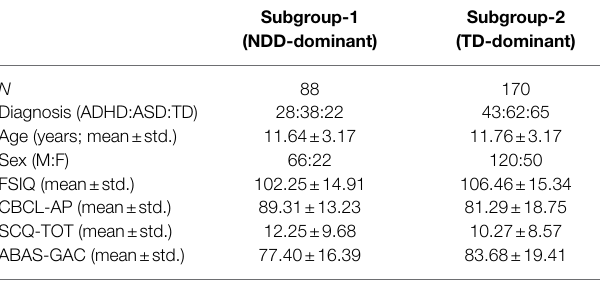
TABLE 3 | Subgroup